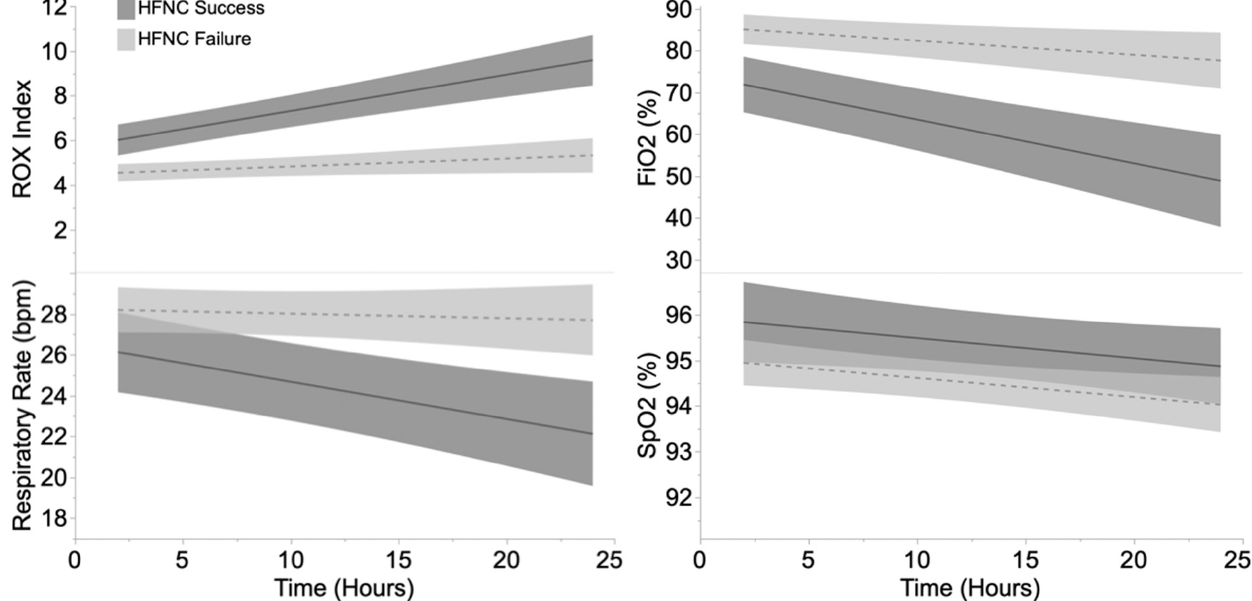
Figure 2. ROX index, respiratory rate (RR), inhaled fraction of oxygen (FiO 2 ), and peripheral saturation of oxygen (SpO 2 ) during high-flow nasal canula (HFNC) support. The continuous (HFNC success) and dotted (HFNC failure) lines show the values predicted by a linear mixed